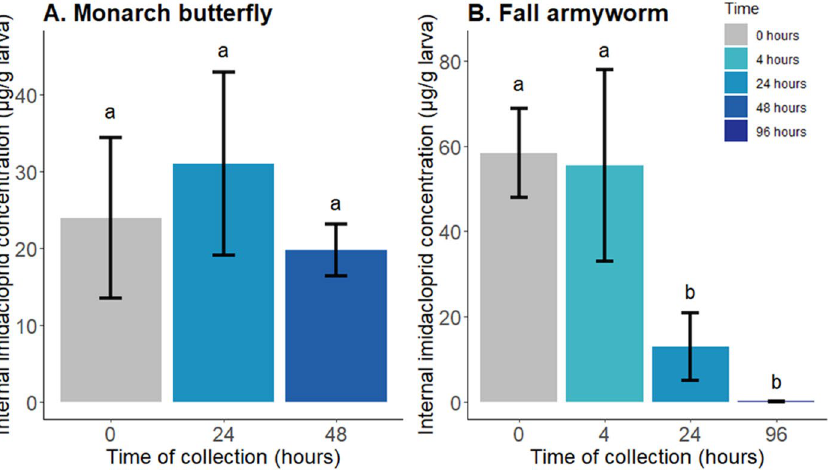
Figure 5. Mean internal concentrations (± standard deviation) of imidacloprid in monarch butterfly ( A ) and fall armyworm ( B ) final instars. Larvae were collected at the following time points after topical treatment with 20 µg imidacloprid : 0 h (both species; larvae), 4 h (fall armyworm; larvae), 24 h (both species; larvae), 48 h (monarch butterfly in arrested pupal ecdysis), and 96 h (fall armyworm as pupae). For each species, different lower-case letters above bars denote significant differences ( p < 0.05) between control and treated larvae using Dunnett’s test for multiple comparisons.